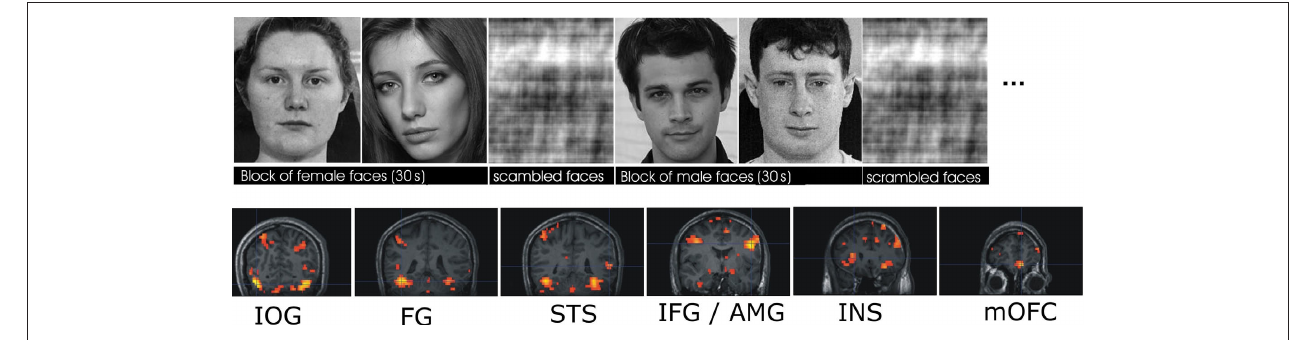
2006). Bottom: Face responsive ROIs from a representative subject. Sections show coronal slices, from posterior to anterior with bilateral activation in the IOG, FG, STS, IFG, AMG, and INS, and activation in medial